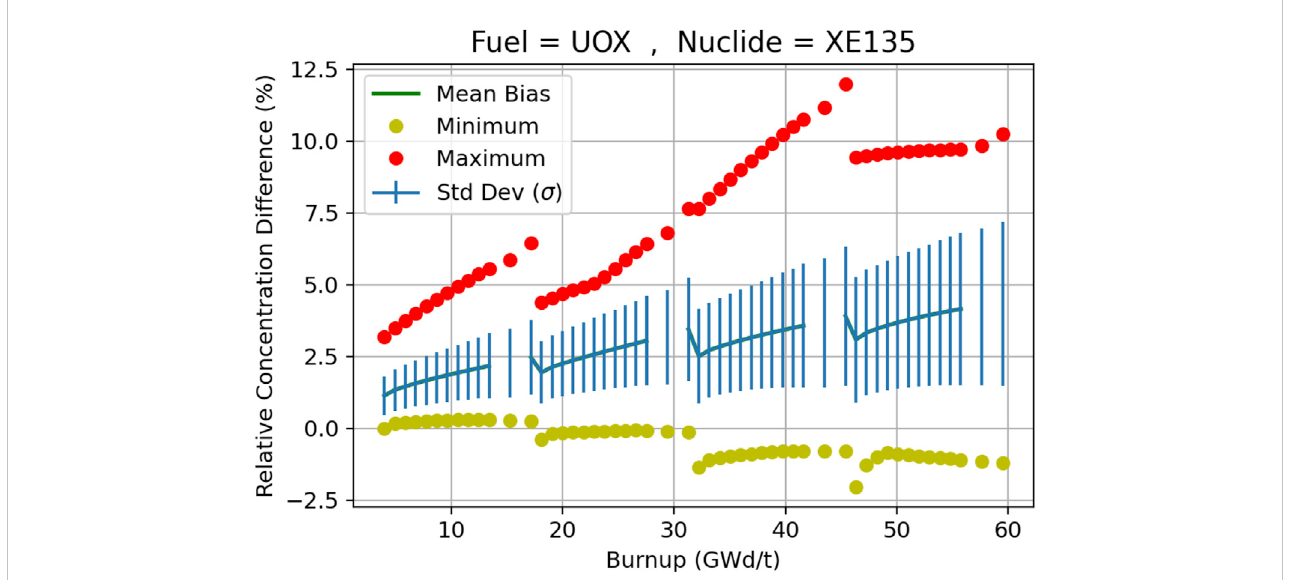
Differences on the 135 Xe concentration, with burnup, between cluster calculations and ILA, for UO 2